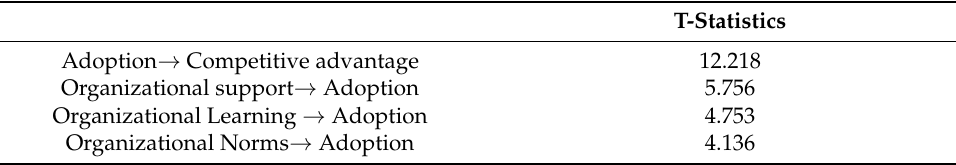
Table 4. Bootstrap results of the model (inner